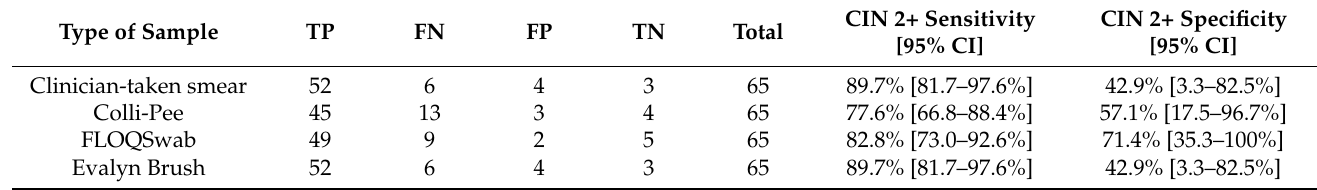
Table 2. Sensitivity and specificity for CIN 2+ in clinician-taken smears (CTS), self-collected urine samples (Colli-Pee), FLOQSwab and Evalyn Brush samples ( n =